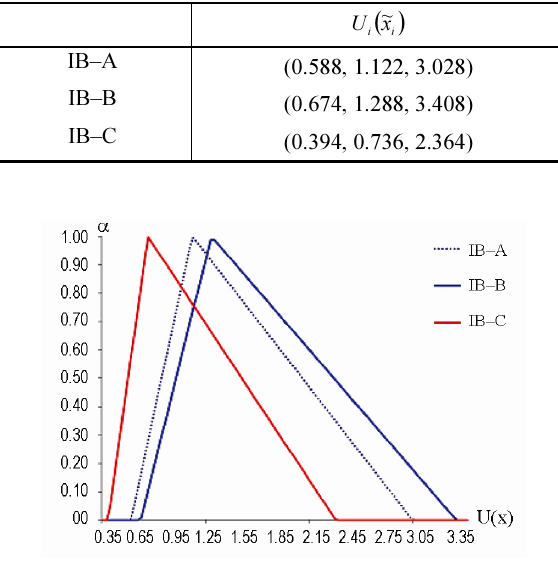
Fig. 5. The membership functions of intelligent building